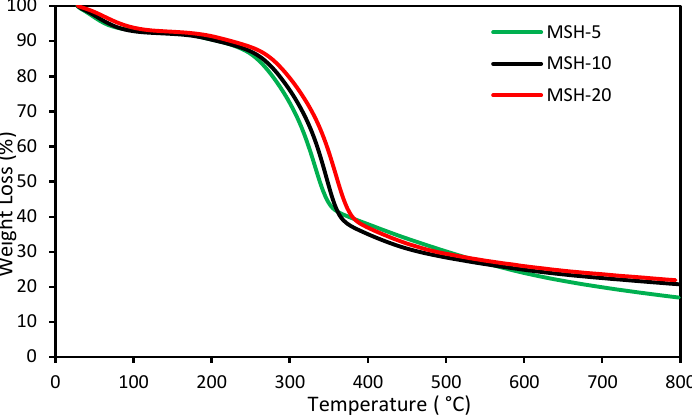
Fig. 2. Weight Loss (%) TG Curves for MSH at 5, 10 and 20 °C min −1